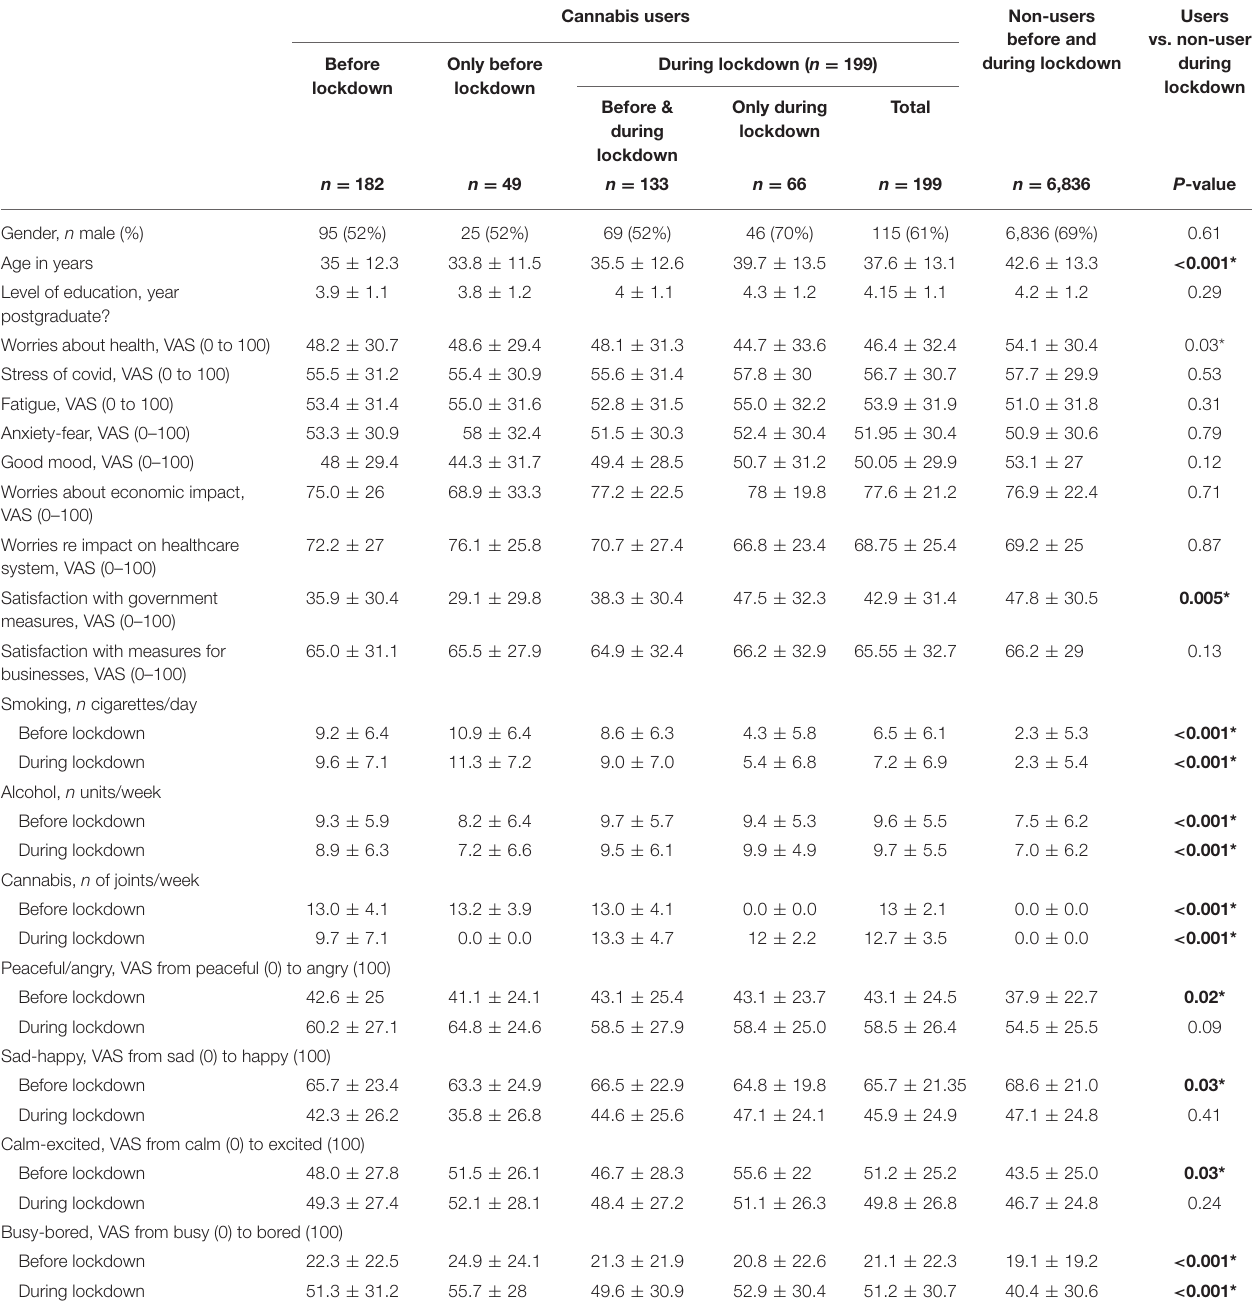
TABLE 1 | Presentation of the data for the overall group and the subgroups of cannabis users and non-users; n (%): number of individuals (percentage) or mean ± standard-deviation.